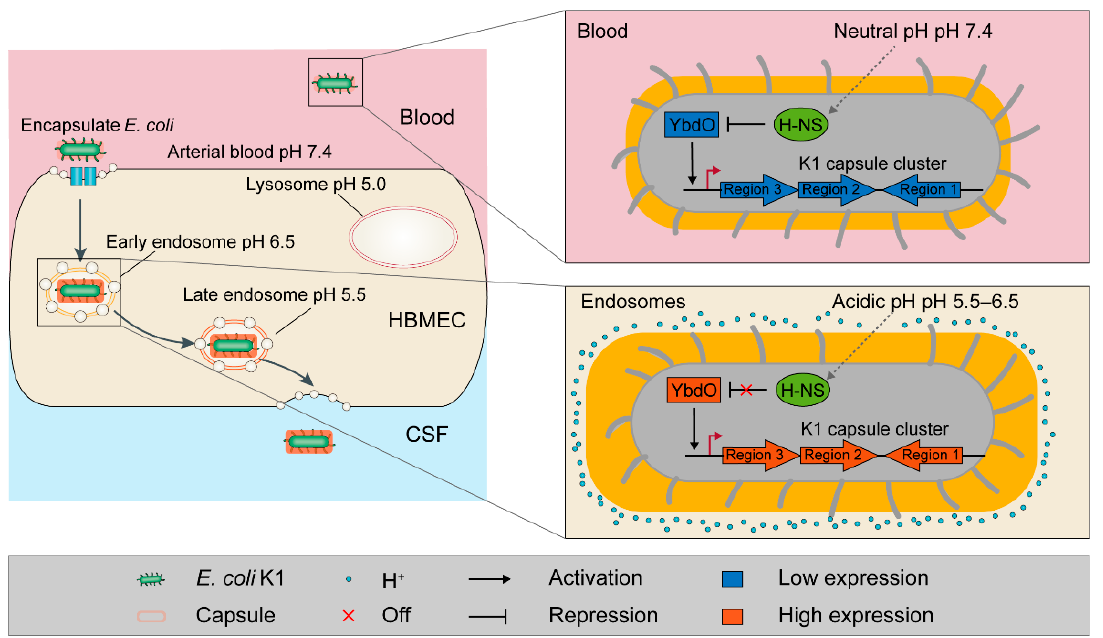
Figure 8. Model of the regulatory pathway of YbdO-mediated signaling in E. coli K1. In the blood, the pH is neutral (7.4), and H-NS binds to the ybdO promoter and represses ybdO expression, thereby inhibiting activation of capsule gene expression. In the endosomes of HBMECs, the pH is acidic (5.5–6.5), which induces H-NS detachment from the promoter to activate ybdO expression, allowing subsequent activation of capsule gene expression by YbdO to promote capsule production.